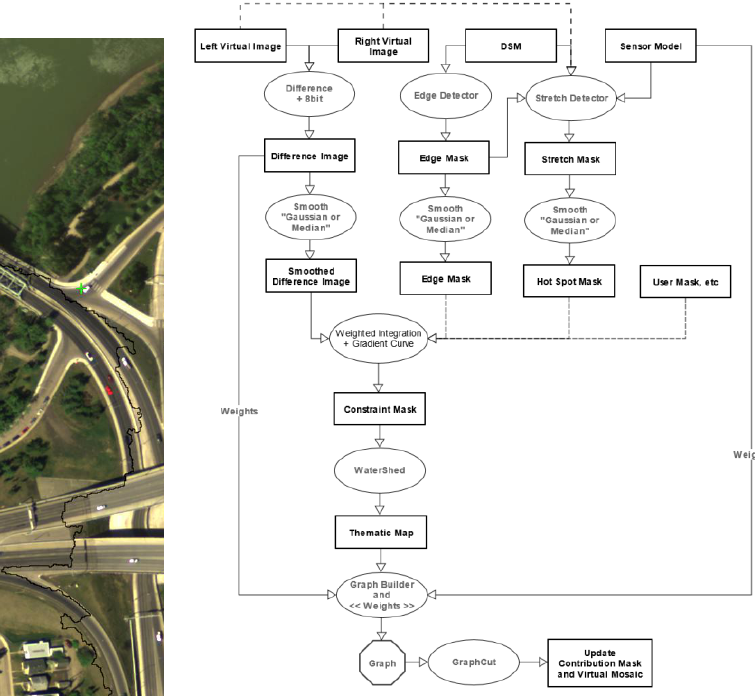
Figure 13. A workflow diagram of the seamline